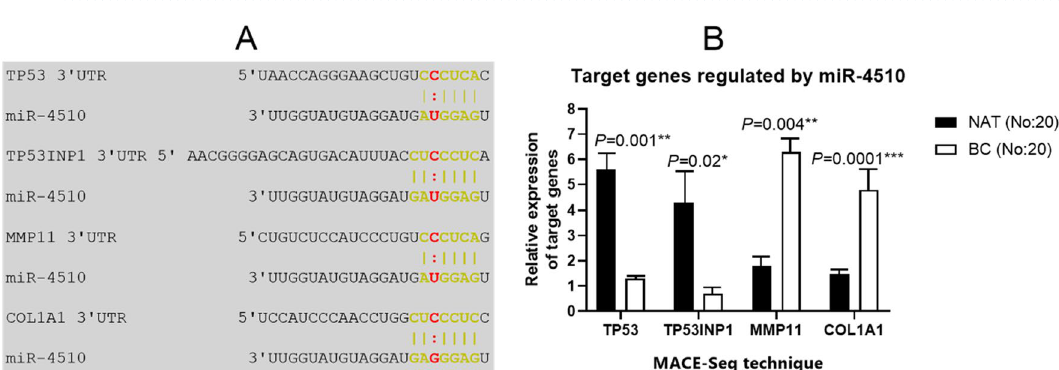
Figure 4. MRNA - miR-4510 interaction and differential expression of its target genes. ( A ) Complementarity of the 3 ′ UTR of target sequence to the miR-4510 binding site which highlighted in green color. A polymorphism (A:C) was upper letter and highlighted in red color. ( B ) Differential expression level of miR-4510 target genes in BC participants compared to NAT. *P < 0.05, **P <